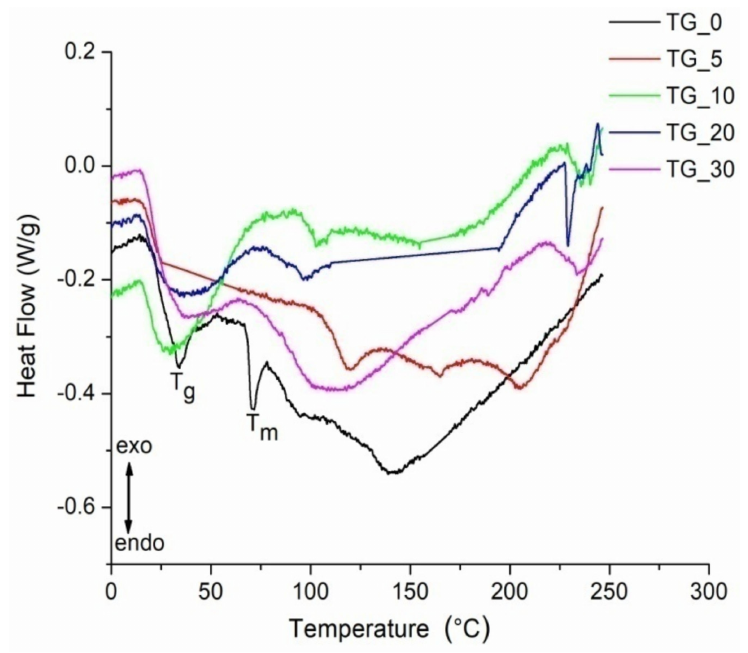
Figure 8. DSC curves of the TG_X films (X − 0, 5, 10, 20, and 30% of tot’hema). Tg and Tm − Endother- mic peaks (denoted for pure gelatin film − TG_0) represent glass transition and melting temperature,